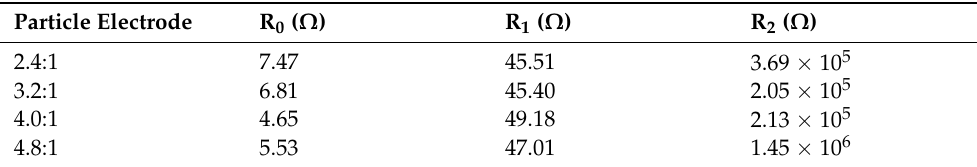
Figure 2. Characterization of particle electrode: ( a ) XRD, ( b ) FTIR and ( c ) EIS. Table 1. The fitted parameters of EIS data for particle electrodes with different mass ratio of ZnCl 2 to eucalyptus sawdust.